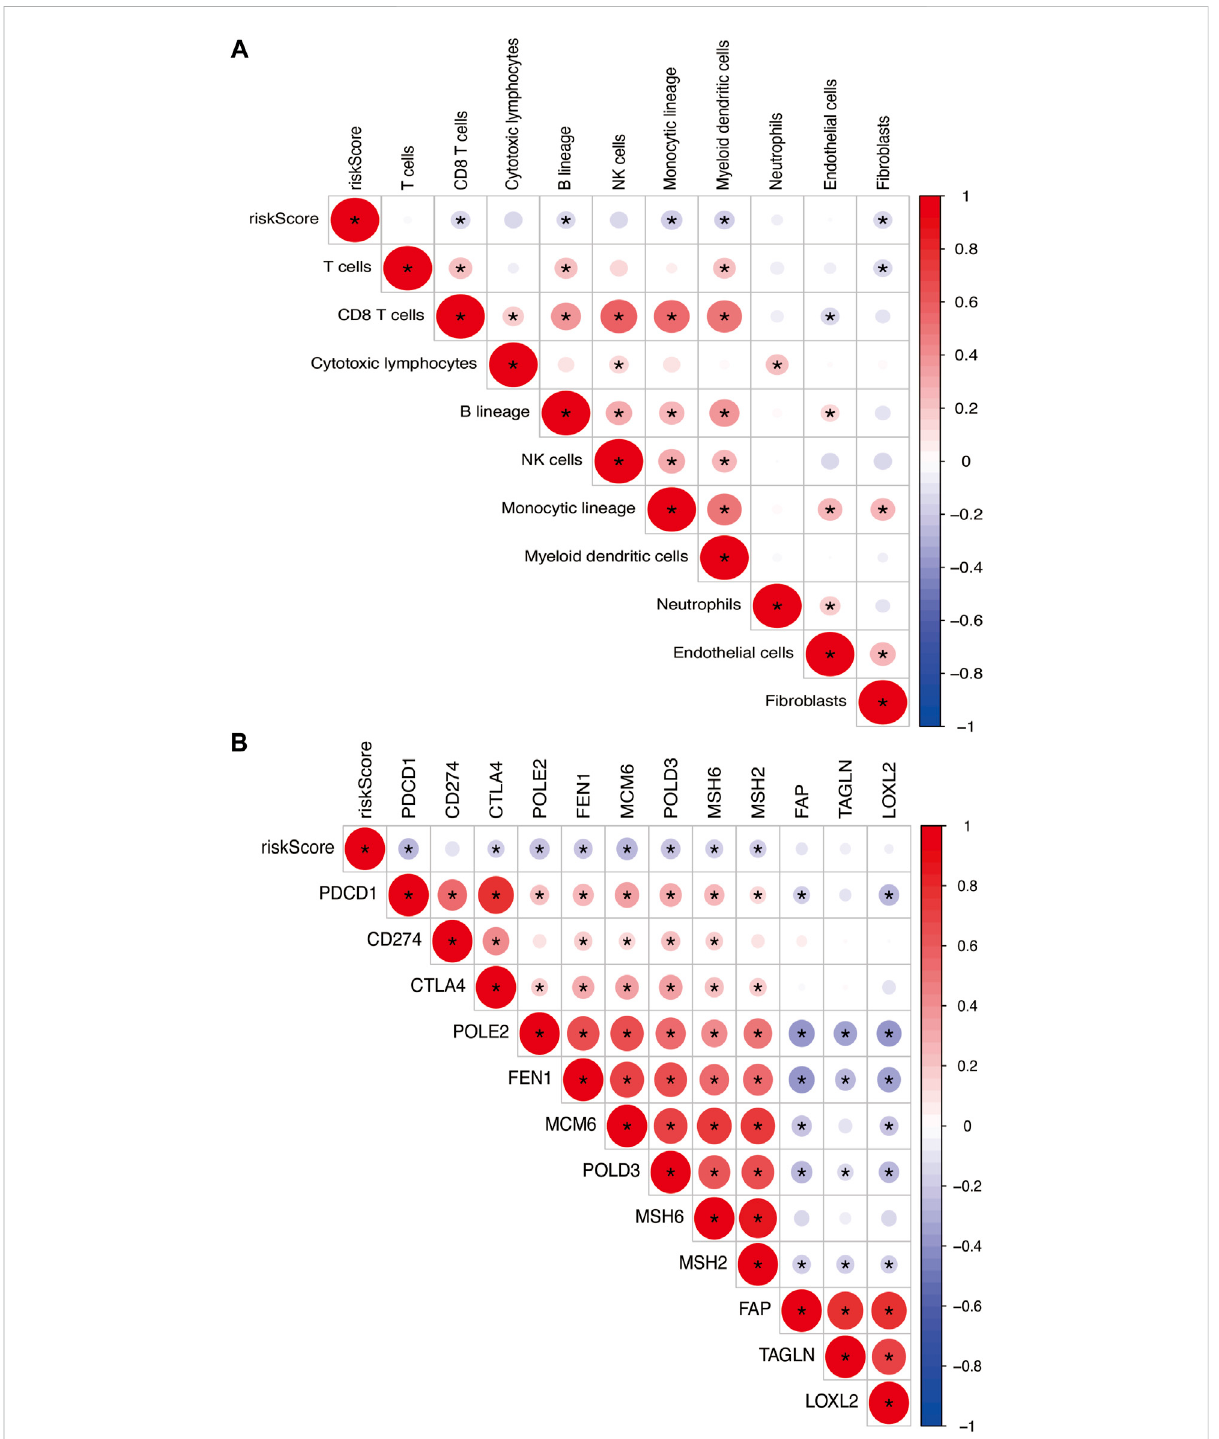
FIGURE 11 (A) Heatmapshowingthecorrelationbetweenriskscoreandimmunecells. (B) SpearmancorrelationanalysisofTME-relatedgenesinPTC.The numberontherightverticalaxisrepresentstheSpearmancorrelationcoef fi cientbetweentwogenes.Theblackasterisk(*)insidethecircleindicates p < 0.05. Red indicates positive correlation. Blue indicates negative correlation. The stronger the correlation, the larger the circle and the deeper the